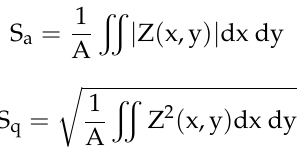
Figure 2. Height 50 × 50 ( µ m) image of surface morphology acquired by AFM in tapping mode for PHA thin films sample ( left ) and its line profile ( right ).